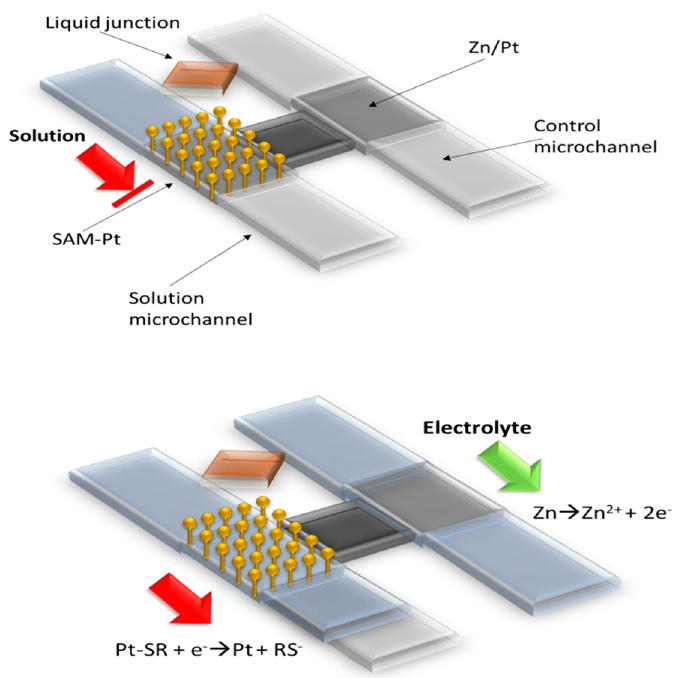
Figure 13. Schematic draw of electrochemically-actuated microvalve based on two electrodes (Zn / PT and modified Pt) described by Biswas et al., based on [131].